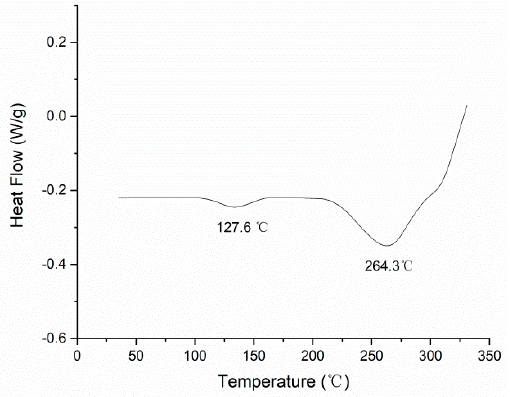
Figure 8. Differential scanning calorimeter (DSC) curve of UDMA/TEGDMA resin.